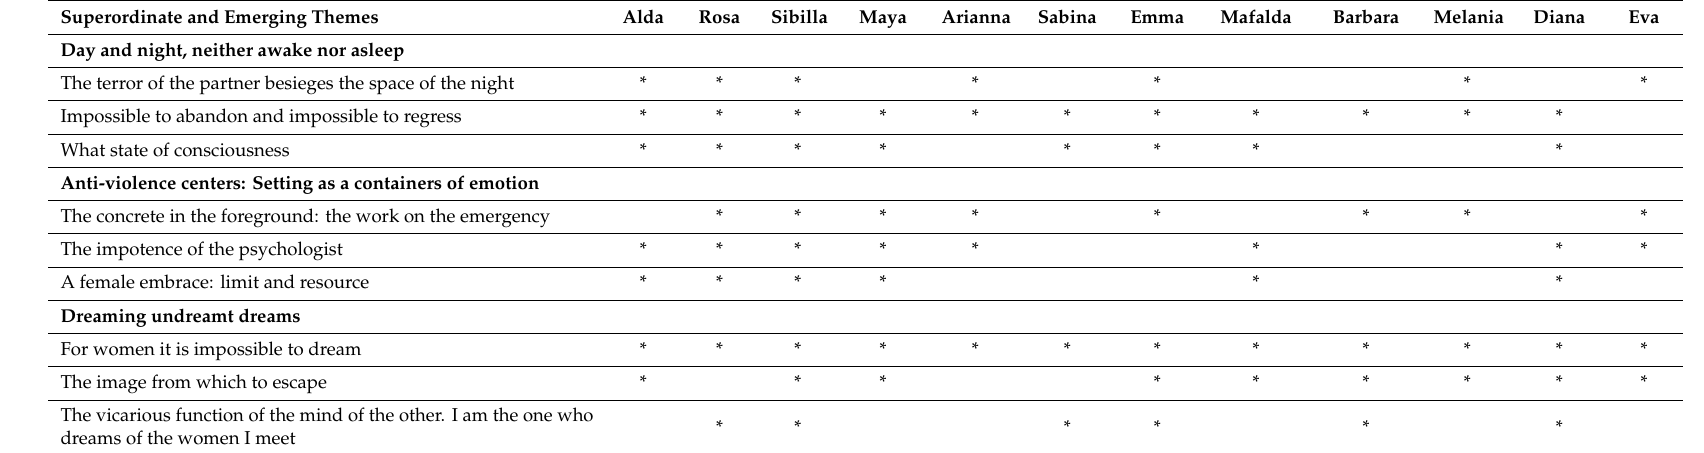
Table 2. Superordinate and subordinate